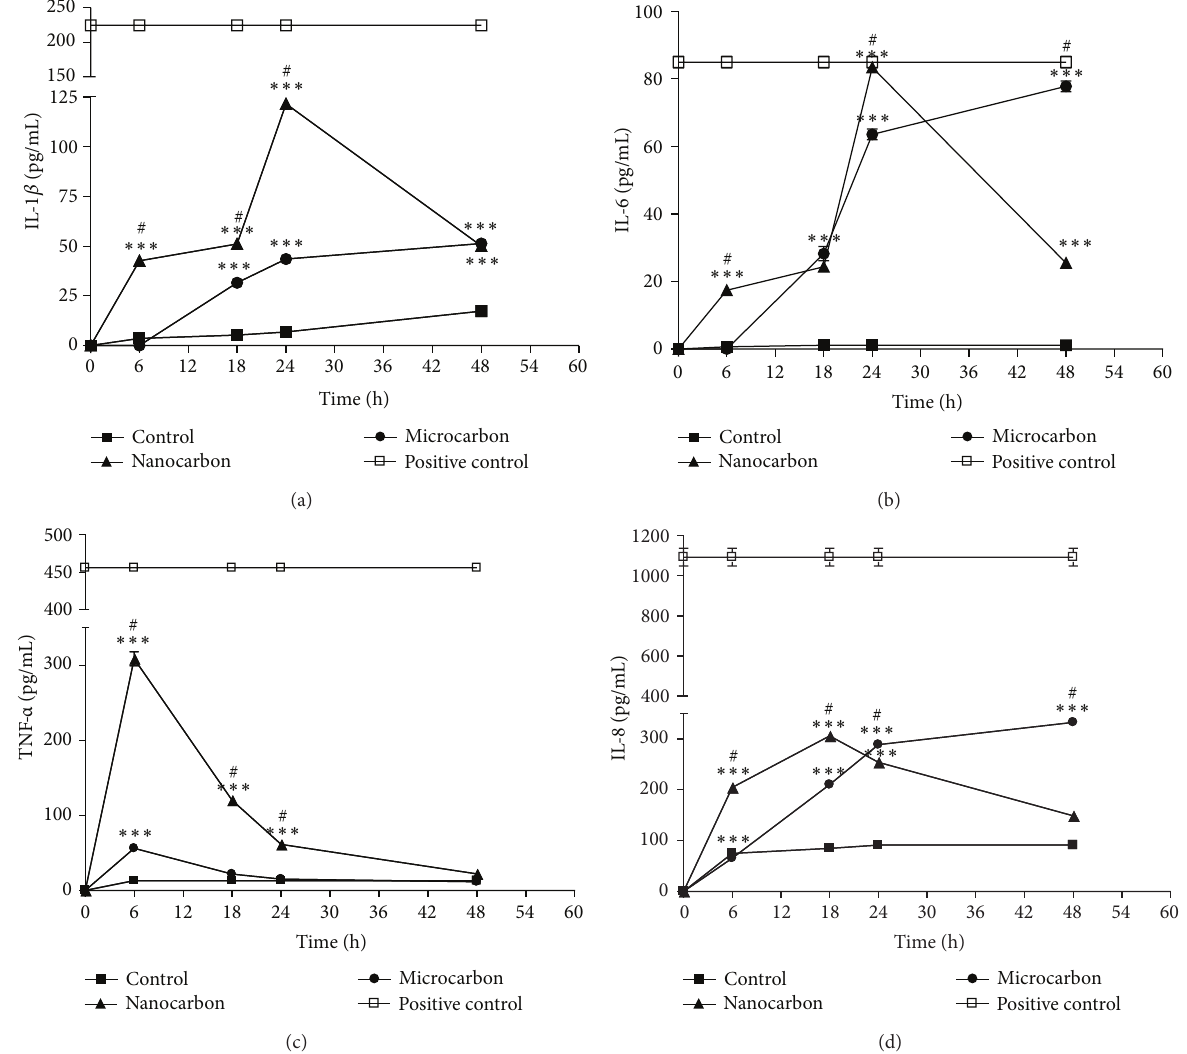
Figure 6: Proinflammatory cytokine and chemokine level in THP-1 cells exposed to carbon particles at their TC-50 concentration (nano carbon: 591.4 𝜇 g/mL and micro carbon 687.1 𝜇 g/mL) for different times (0, 6, 18, 24, and 48 h) as determined by ELISA. A positive control for each assay was run in parallel as per manufacturer’s instruction. (a) IL-1 𝛽 level, (b) IL-6 level, (c) TNF- 𝛼 level, and (d) IL-8 level. Results are presented as mean ± SEM of three independent replicate experiments. Significance is indicated by ∗∗∗ 𝑃 < 0.001 versus control. # 𝑃 < 0.001 indicates significant difference between the particle